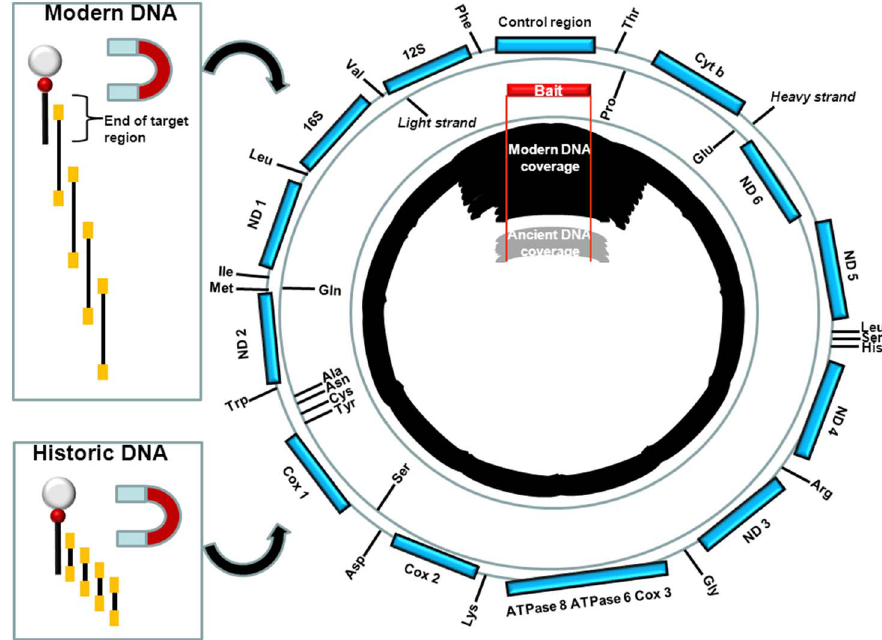
Figure 5. Model of CapFlank. The bead bound biotinylated baits are shown on the left of the figure as a grey circle (magnetic bead) bound to the biotinylated bait, black line attached to red circle. Library molecules are displayed as insert (black) with library adaptors (orange). The end of the homology between bait and target is shown to represent the last nucleotides of a targeted region. Library molecules with homology to the unbound portion of bait immobilized library molecules can hybridize to the unbound fraction. The process is iterative with newly bound molecules hybridizing to library molecules with further extending unbound portions becoming enriched by the growing contigs bound to the baits. Historic DNA differs in that the insert sizes are much shorter so much less unbound homologous sequence is available for extending beyond the target region. The effects are shown for mitochondrial genomes whereby the targeted region (baits shown in red with red lines delimiting the ends of the baits sequence) are highly enriched for both modern and historic DNA and that reads are enriched for the full mitochondrial genome with a decrease in number by distance and a far faster decrease by distance for historic DNA.